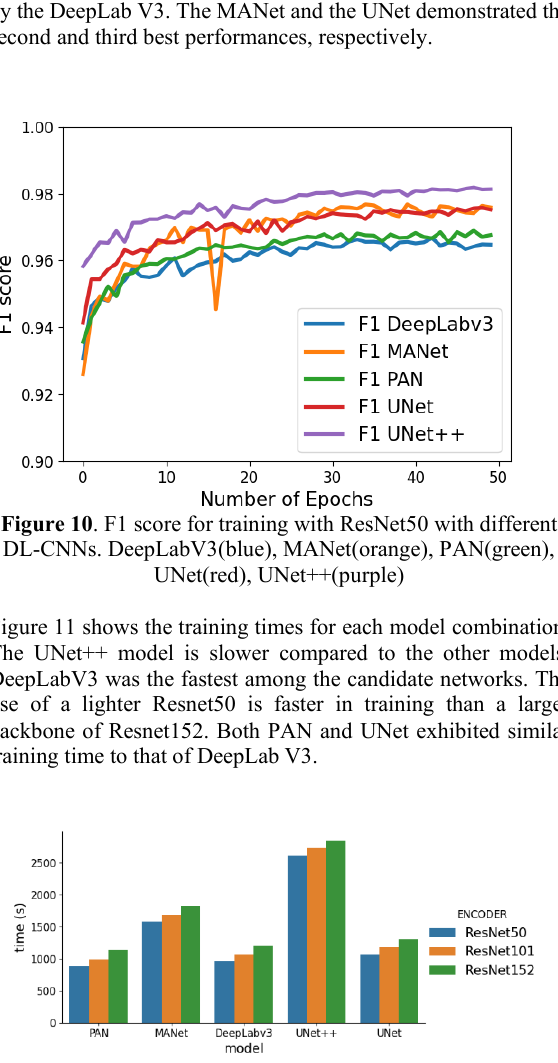
Figure 11 . Time taken for training for different models with different backbones combinations.